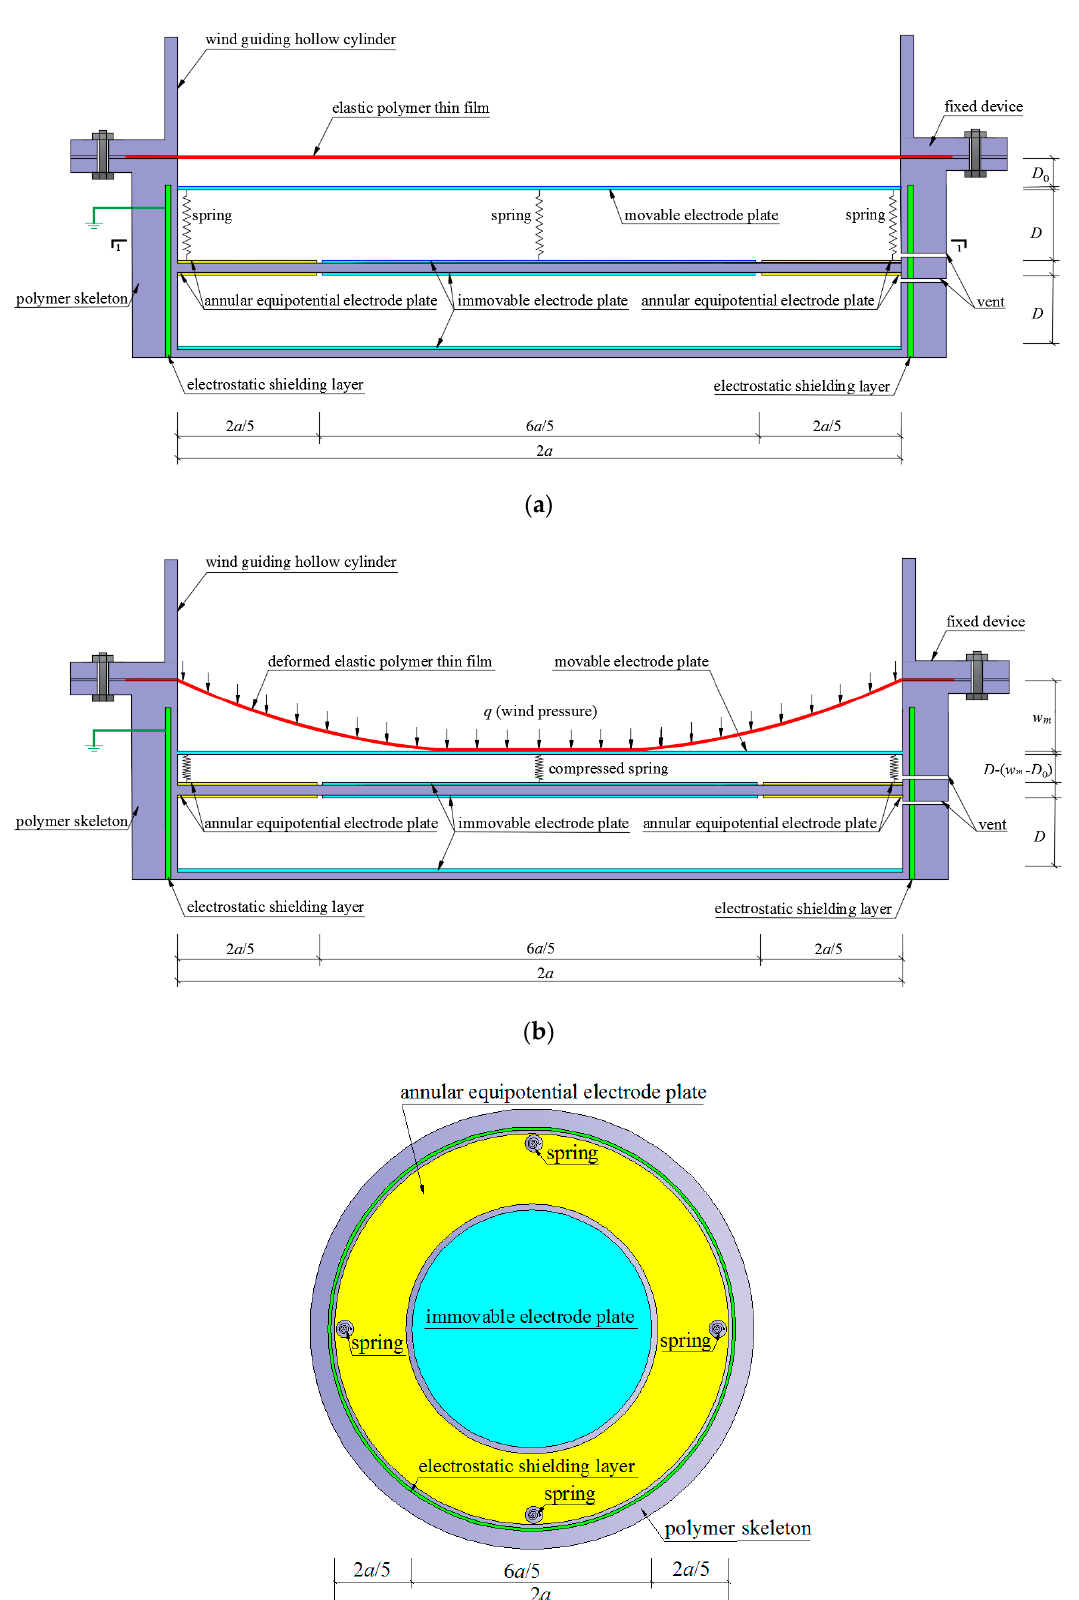
Figure 1. A schematic view of structure and operating principle of the developed capacitive wind-pressure sensor: ( a ) initial state; ( b ) working state; ( c ) sectional view.